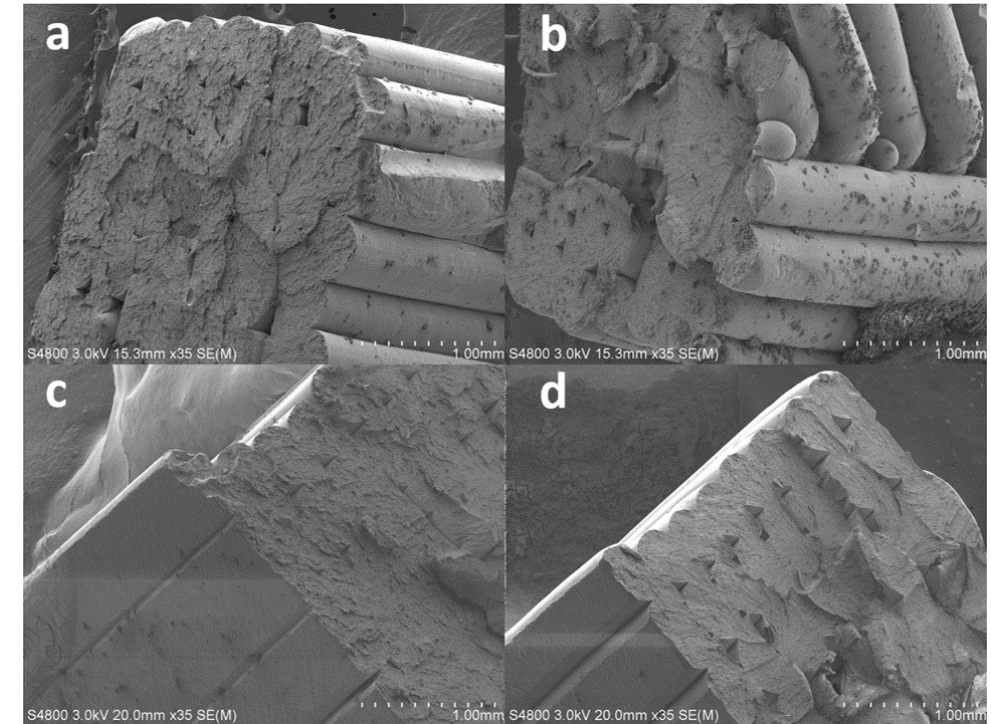
Figure 12. SEM images of the broken 3D printed specimens with a 0.38 mm layer thickness: ( a ) R-45-0.38 mm, ( b ) R-90-0.38 mm, ( c ) S-45-0.38 mm, and ( d ) S-90-0.38 mm.